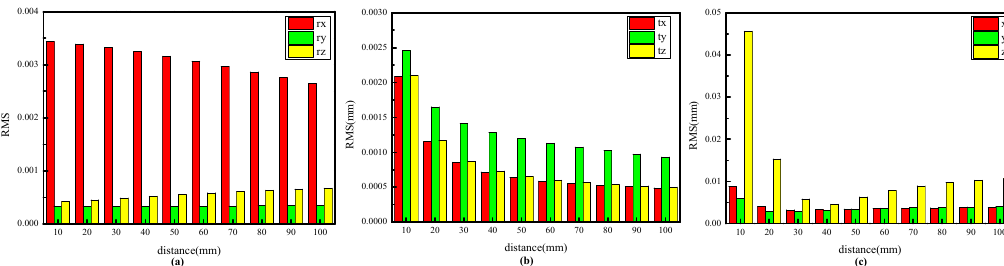
Figure 6. RMSEs of the extrinsic parameters based on the proposed method. ( a ) RMSEs of r x , r y and r z at different distance levels; ( b ) RMSEs of t x , t y and t z at different distance levels; ( c ) RMSEs of the 3D coordinates of the feature points at different distance levels.